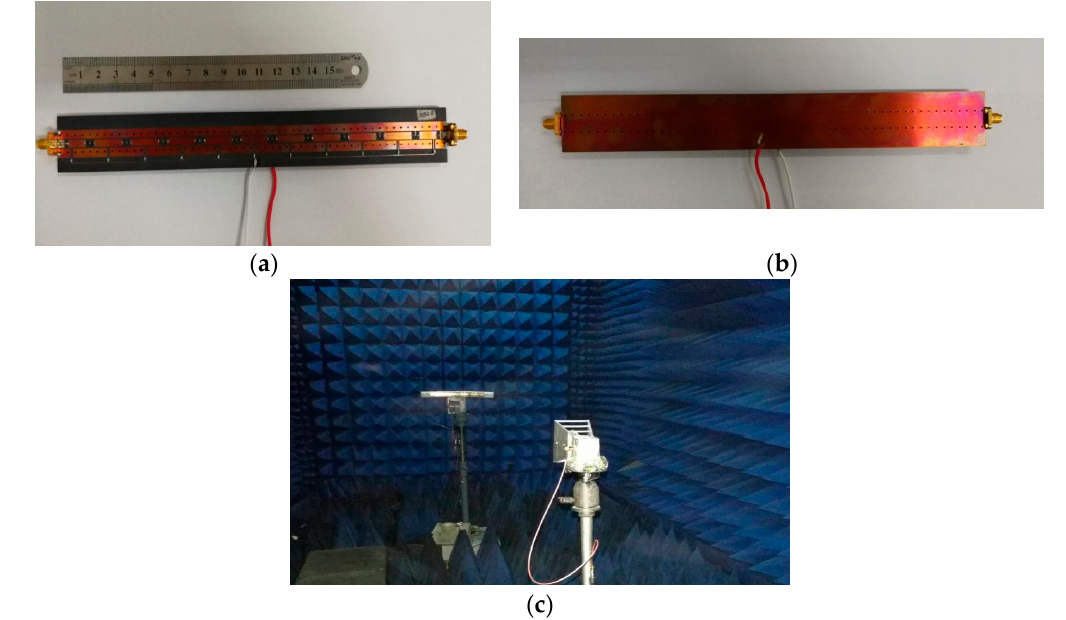
Figure 9. Photograph of the fabricated 10-unit LWA prototype. ( a ) Top view; ( b ) Bottom view; ( c ) Measurement installation. Appl. Sci. 2020 , 10 , x FOR PEER REVIEW